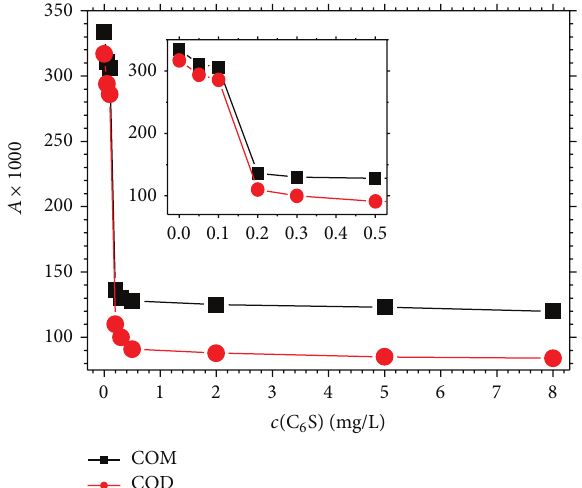
Figure 10: Sedimentation coefficient of suspensions of submicron COM and COD crystallites in the presence of different concentra- tions of C 6 S after placement for